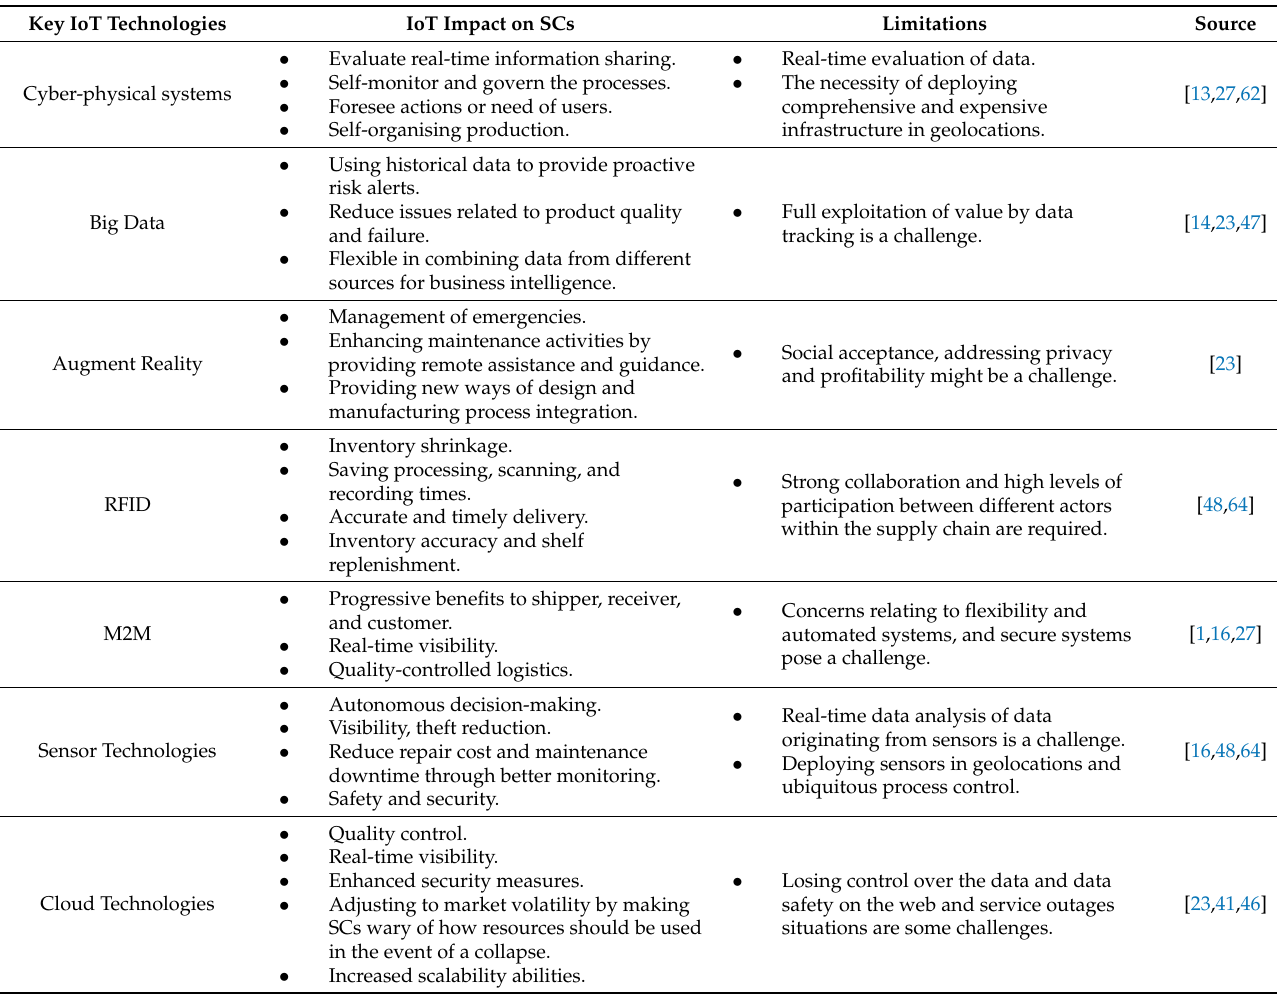
Table 6. Key IoT technologies used in the supply chain, adopted from Kalsoom et al.